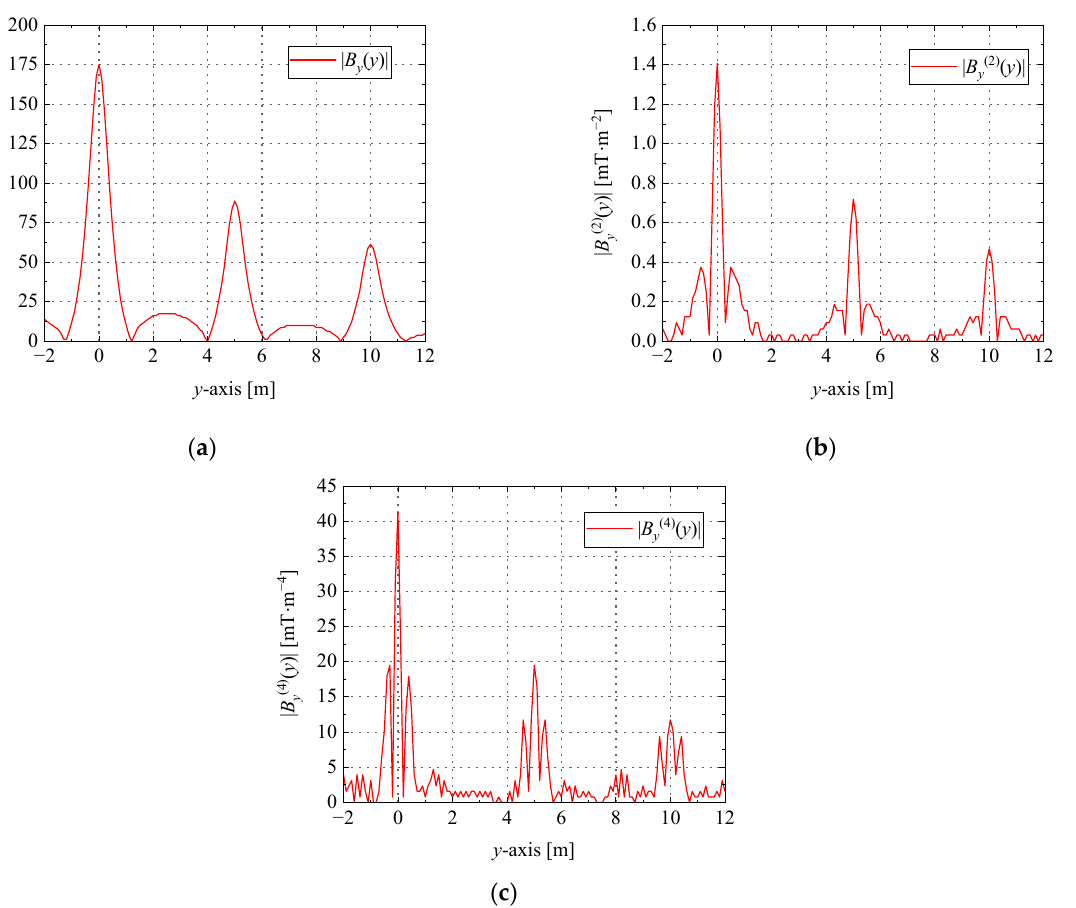
Figure 5. The curve of magnetic flux density differential at the survey line x = 6 m: ( a ) the absolute value curve of magnetic flux density; ( b ) the second-order differential absolute value curve of the magnetic flux density; ( c ) the fourth-order differential absolute value curve of the magnetic flux density.